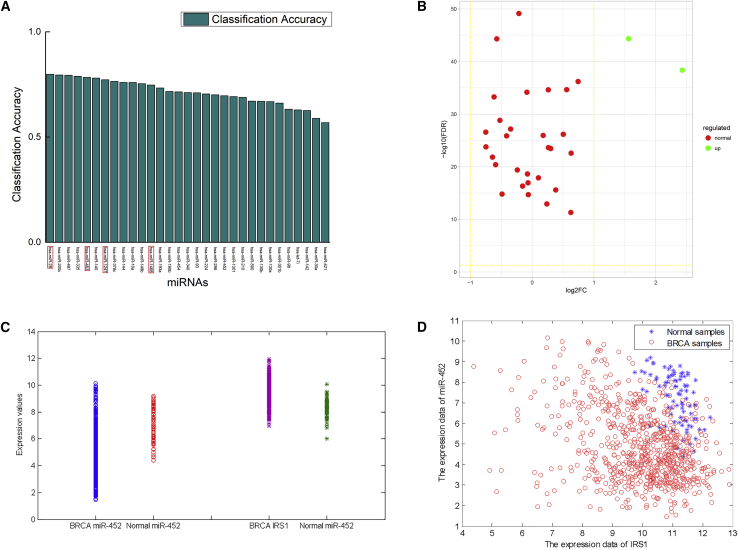
The 31 miRNAs in 136 MTIs with [ACC(miRNA-mRNA) > 0.9, ACC(miRNA) < 0.8, ACC(mRNA) < 0.8] for Breast Cancer(A) The relationship between these miRNAs and cancer. The miRNAs in the red rectangular boxes are not experimentally confirmed to be associated with BRCA. (B) The volcano map of the above 31 miRNAs. Only 2 of 31miRNAs are differentially expressed. (C) The one-dimensional scatterplot of single miR-452 and IRS1 expression values in normal and cancer samples. The left two lines represent the expression value of miR-452 in BRCA and normal tissues, and the right two lines represent the expression value of IRS1 in BRCA and normal tissues. (D) The two-dimensional scatterplot of miRNA-mRNA interaction. The abscissa and ordinate represent the expression values of IRS1 and miR-452.